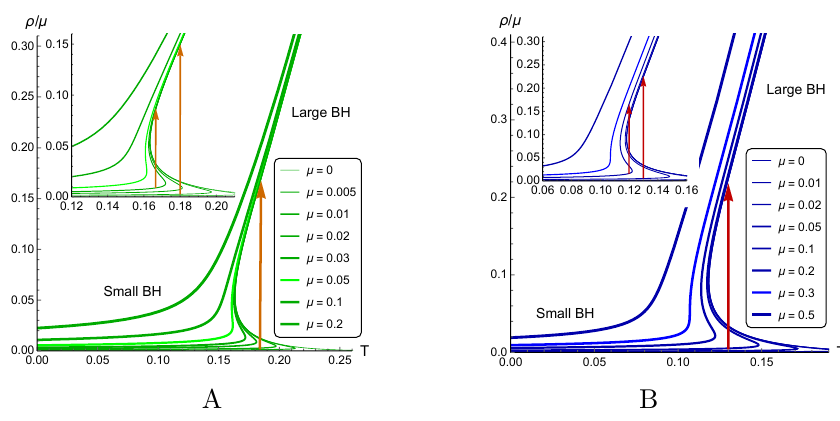
Figure 7 . Density ρ/µ ( T ) for different µ for ν = 1 (A) and ν = 4 . 5 (B); c = 0 . 227 , c B = 0 . z ) is accompanied by a sharp rise of the density for any appropriate chemical potential. h On figure 7 c = 0 , but for c close to zero enough to preserve ambiguity of T ( z B B density curves will differ from the zero magnetic field case